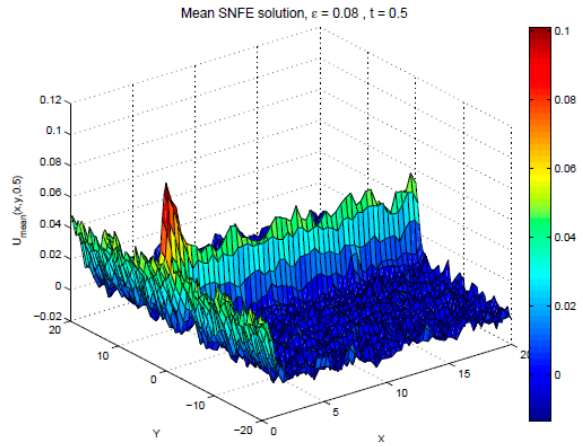
Figure 7. Snapshots of the solution of Example 1 at time t = 0.5: up- E = 0; down, left-hand side - E = 0.04; down, right- hand side - E = 0.08